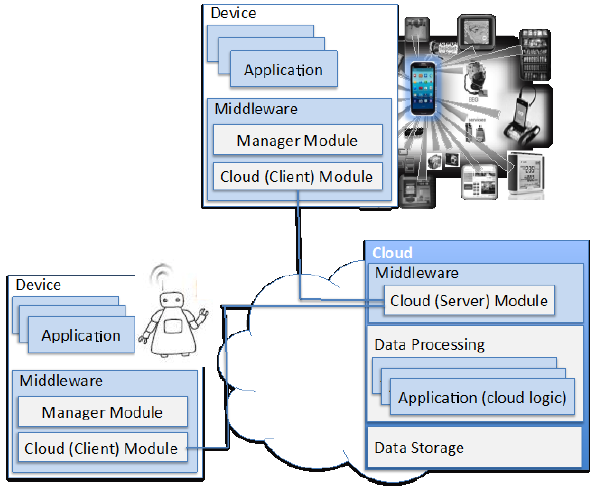
Figure 1. System Architecture and its Components.